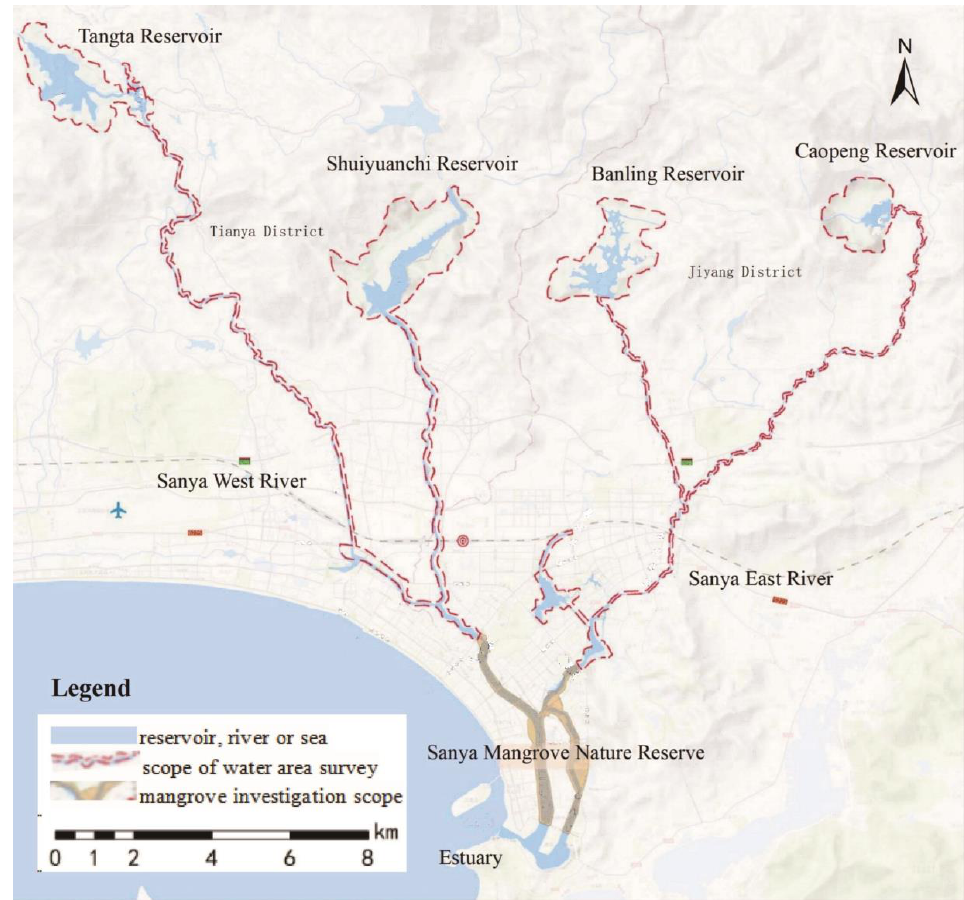
Figure 1. Map of Sanya River Basin in Sanya City, Hainan Province, China. The study area includes Tangta Reservoir and Shuiyuanchi Reservoir on the West River of Sanya, Banling Reservoir and Caopeng Reservoir on the East River of Sanya, and the mangrove nature reserve in the city